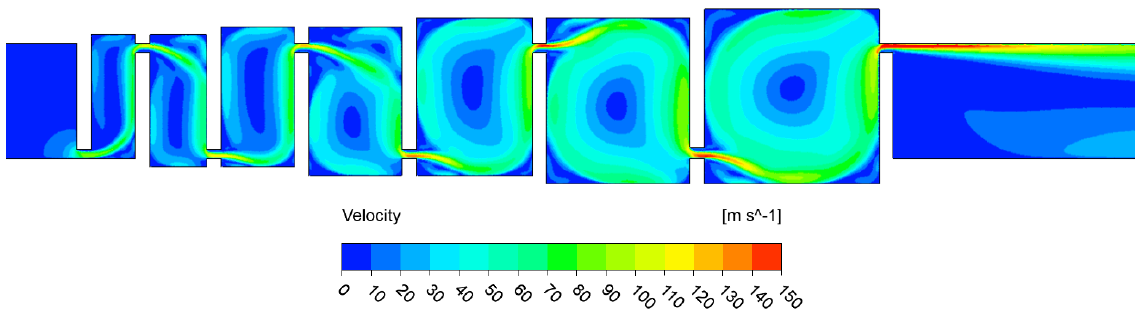
Figure 14. Velocity fields in the designed geometry as per variant B for p in /p out = 2.4, T in = 300 K, p out = 10 5 Pa.